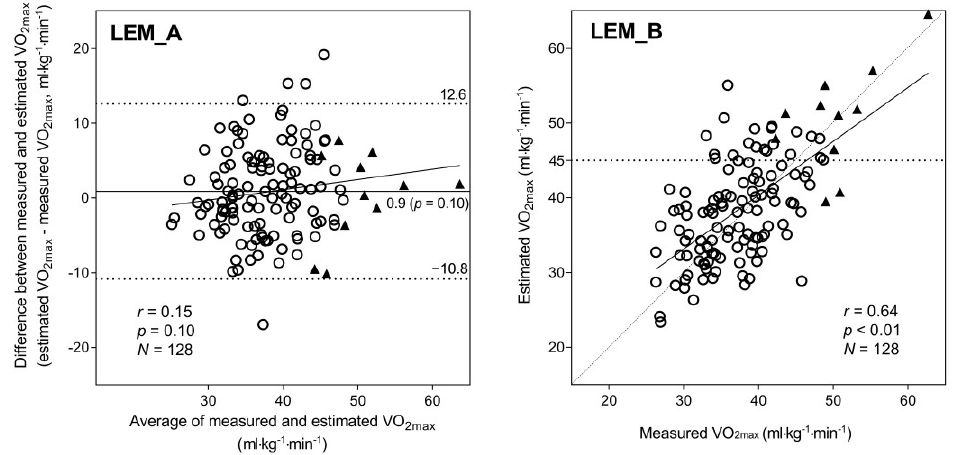
Figure 2. Bland–Altman plot ( A ) and correlation chart ( B ) with mVO 2max and eVO 2max using the